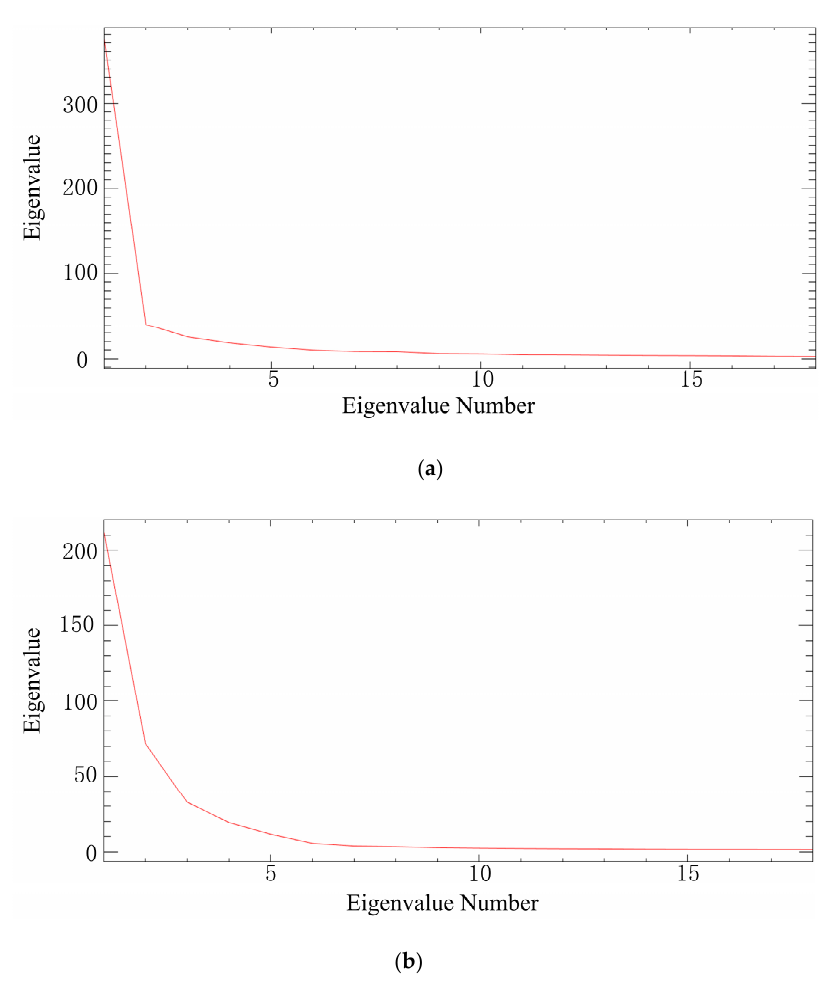
Figure 4. ( a ) The MNF transform eigenvalue curve of the Longkou area; ( b ) the MNF transform eigenvalue curve of the Honghu area.